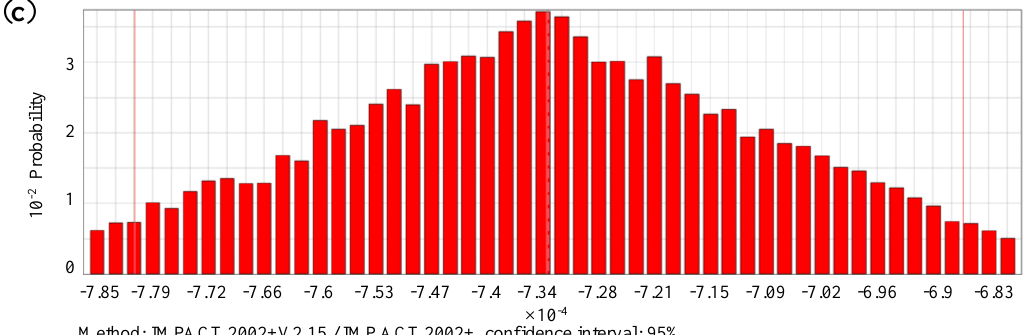
S-1 vs. S-2:aAs shown in Figure 9a and Table S4, the uncertainty analyses show that S−1 vs. S−2:aAs shown in Figure 9a and Table S4, the uncertainty analyses show that with a with a confidence interval of 95%, the mean values of the di ff erences (S-2’s minus S-1’s) for confidence interval of 95%, the mean values of the differences (S−2’s minus S−1’s) for each of the each of the midpoint life cycle impacts are expected to be − 1.730E − 03 kg SO 2 eq for aquatic midpoint life cycle impacts are expected to be −1.730E−03 kg SO 2 eq for aquatic acidification, acidification, − 2.798E + 00 kg TEG water for aquatic ecotoxicity, − 7.195E − 05 kg PO 4 P-lim for −2.798E+00 kg TEG water for aquatic ecotoxicity, −7.195E−05 kg PO 4 P-lim for aquatic eutrophication, aquatic eutrophication, − 1.251E − 02 kg C 2 H 3 Cl eq for carcinogens, − 3.734E − 01 kg CO 2 eq for global −1.251E−02 kg C 2 H 3 Cl eq for carcinogens, −3.734E−01 kg CO 2 eq for global warming, −8.306E+00 warming, − 8.306E + 00 BqC − 14 eq for ionizing radiation, 1.822E − 01 m2org.arable for land occupation, BqC−14 eq for ionizing radiation, 1.822E−01 m2org.arable for land occupation, −4.883E−02 MJ surplus − 4.883E − 02 MJ surplus for mineral extraction, − 2.866E − 03 kg C for mineral extraction, −2.866E−03 kg C 2 H 3 Cl eq for non-carcinogens, −5.770E+00 MJ primary for non- 2 H 3 Cl eq for non-carcinogens, − 5.770E + 00 MJ primary for non-renewable energy, − 4.712E − 08 kg CFC − 11 eq for ozone layer depletion, renewable energy, −4.712E−08 kg CFC−11 eq for ozone layer depletion, −4.134E−04 kg PM2.5 eq for − 4.134E − 04 kg PM2.5 eq for respiratory inorganics, − 4.917E − 04 kg C respiratory inorganics, −4.917E−04 kg C 2 H 4 eq for respiratory organics, and −7.792E−03 kg SO 2 eq for 2 H 4 eq for respiratory terrestrial acid/nutri, 2.443E+00 kg TEG soil for terrestrial ecotoxicity. The probabilities that S−1 ≥ S−2 for the midpoint impacts are: 74.1% for aquatic acidification, 51.71% for aquatic ecotoxicity, 77.45%